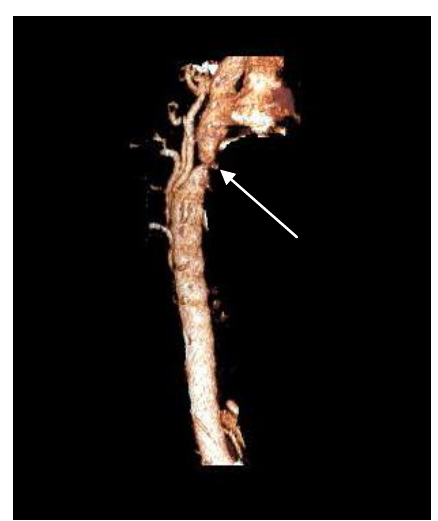
Figure 1. The 3.5 mm aortic coarctation was noted in the upper esophageal view of the three dimensional echocardiography and